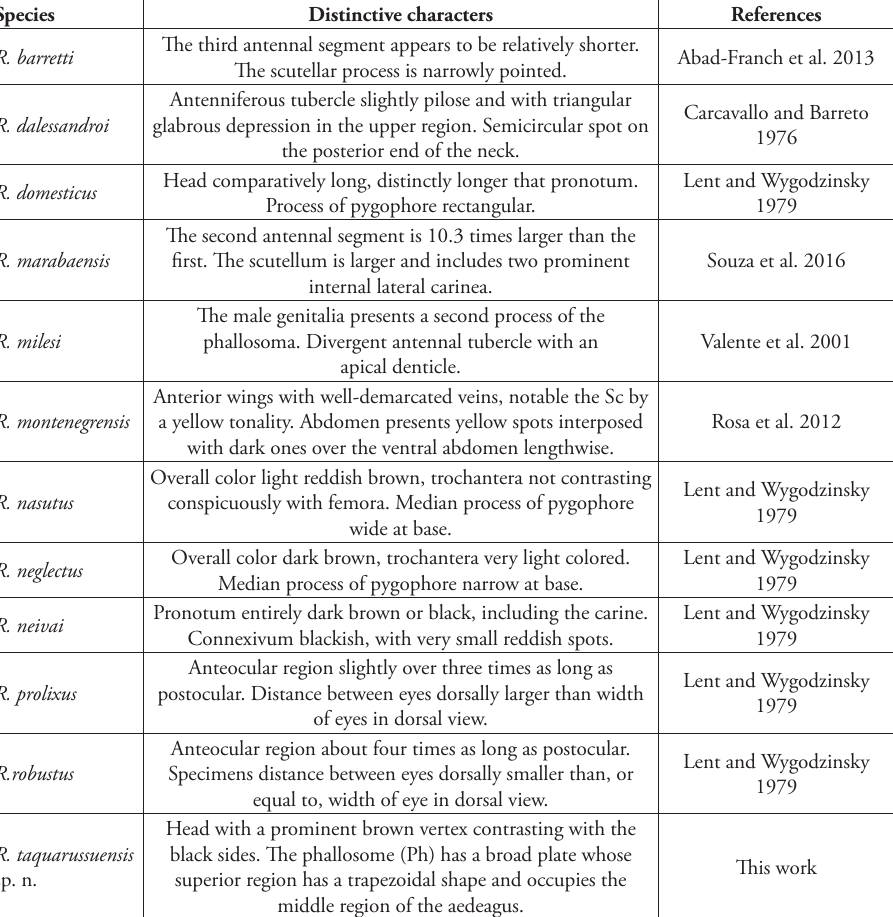
Table 3. Distinguishing characters among twelve species of the group Rhodnius prolixus. Species Distinctive